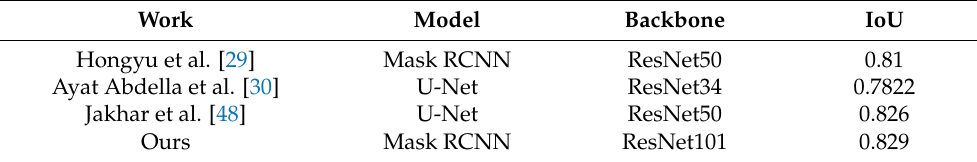
Table 11. Comparison with existing models on the basis of